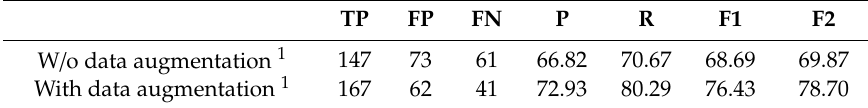
Table 6. Results with and without data augmentation on ETIS-Larib polyp